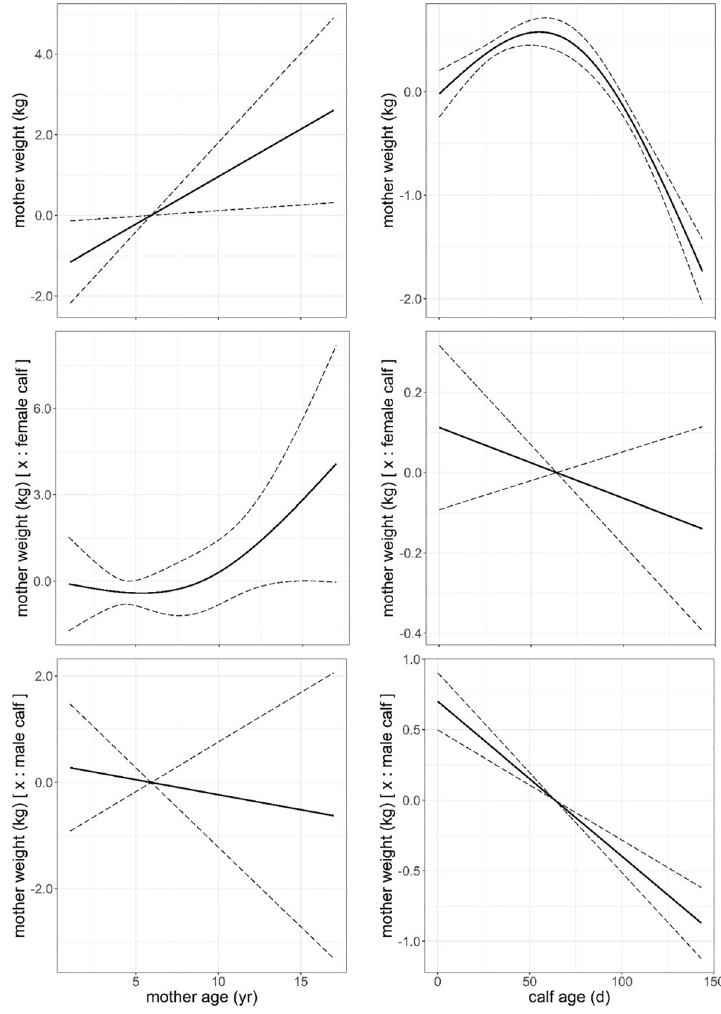
Fig 5. Predicted mother weight (kg) against mother age (years) and calf age (days) and the additive effect of bearing a male or a female through lactation from model in Table 6. Dashed line: ± standard error. Response variable has been centred by subtraction of the mean